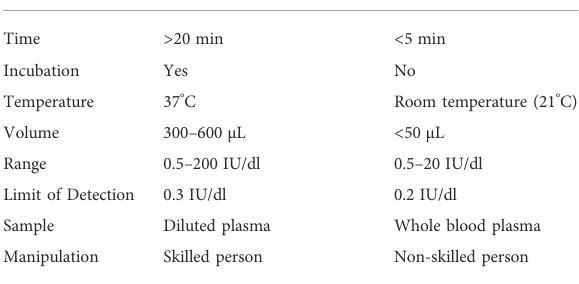
TABLE 1 Comparison of the conventional and one-step